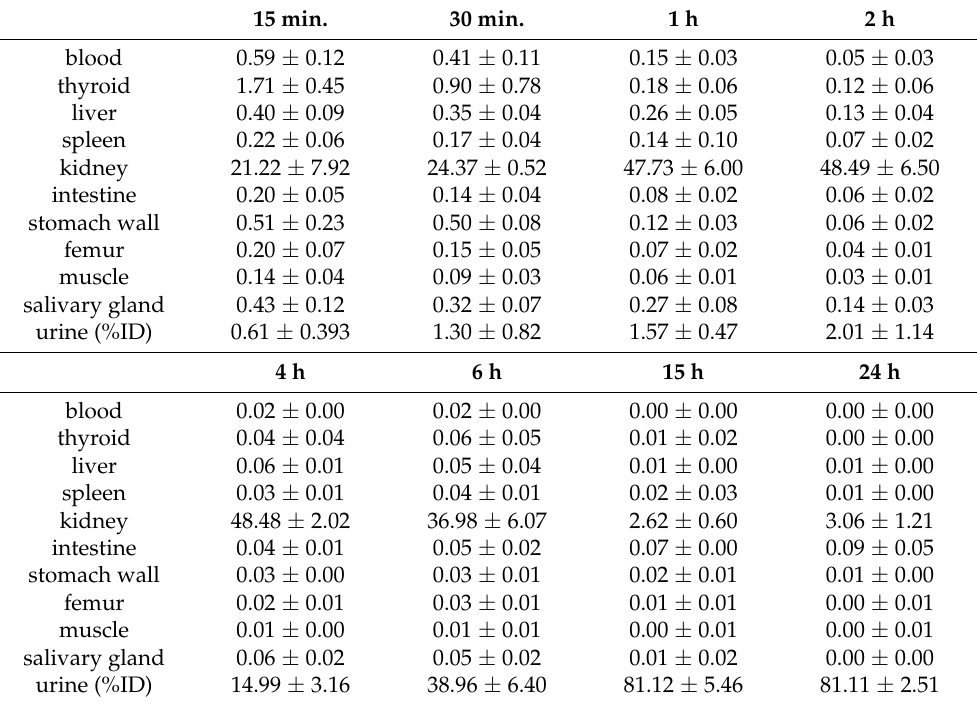
Table 7. Results of pharmacokinetics study of [ 99m Tc]Tc-PSMA-T4 complex in Wistar rats ( n = 5) after intravenous administration (%ID/g, mean ± SD).